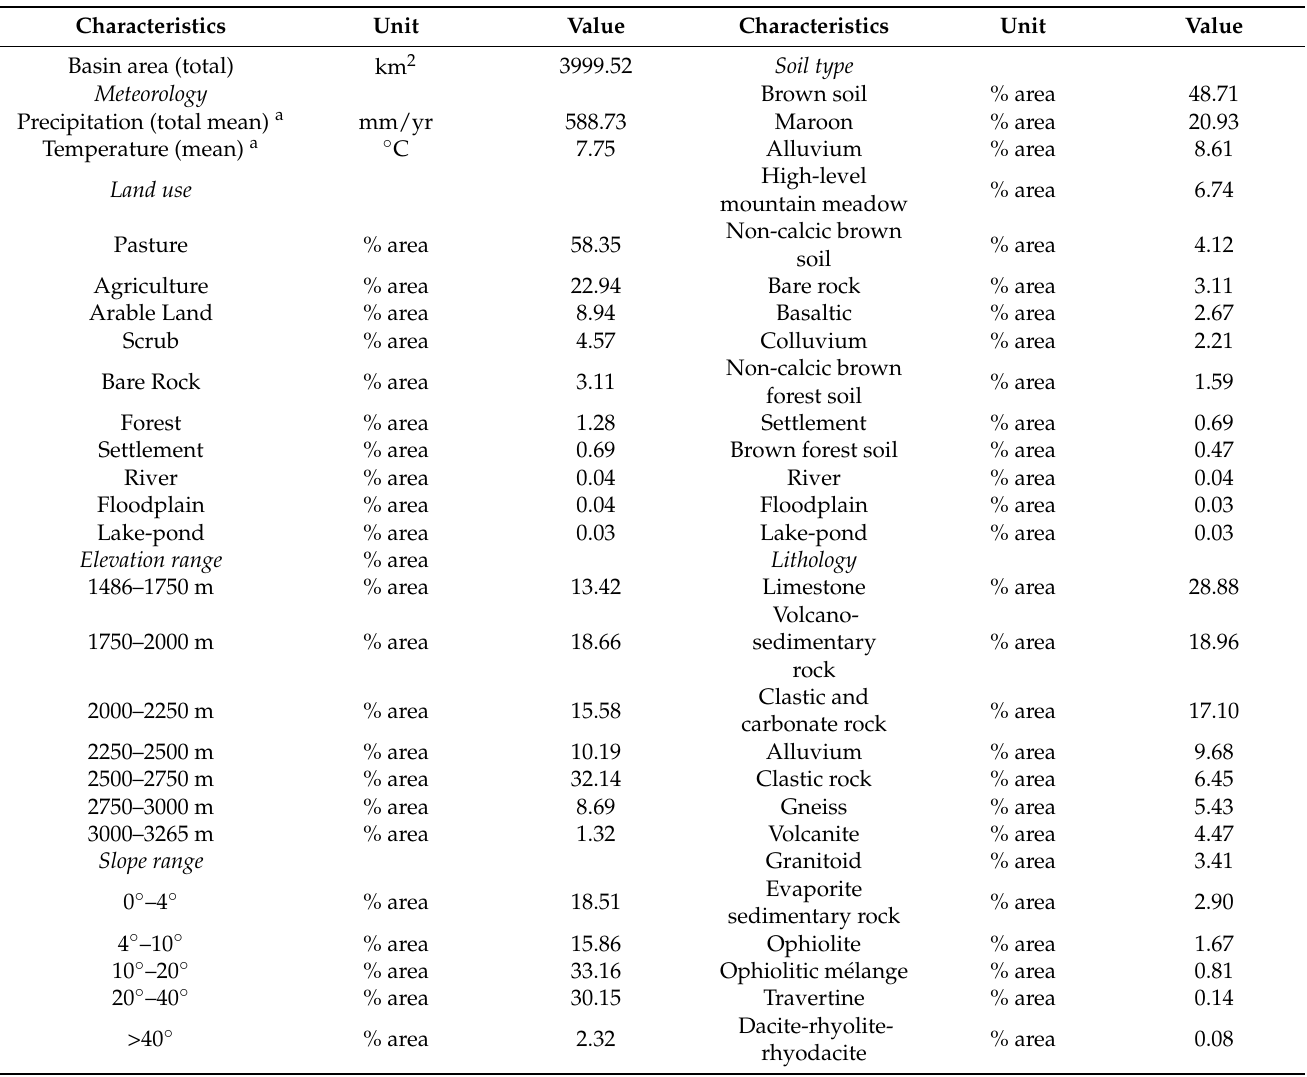
Table 1. Basic characteristics of the Upper Coruh River Basin (UCRB), NE